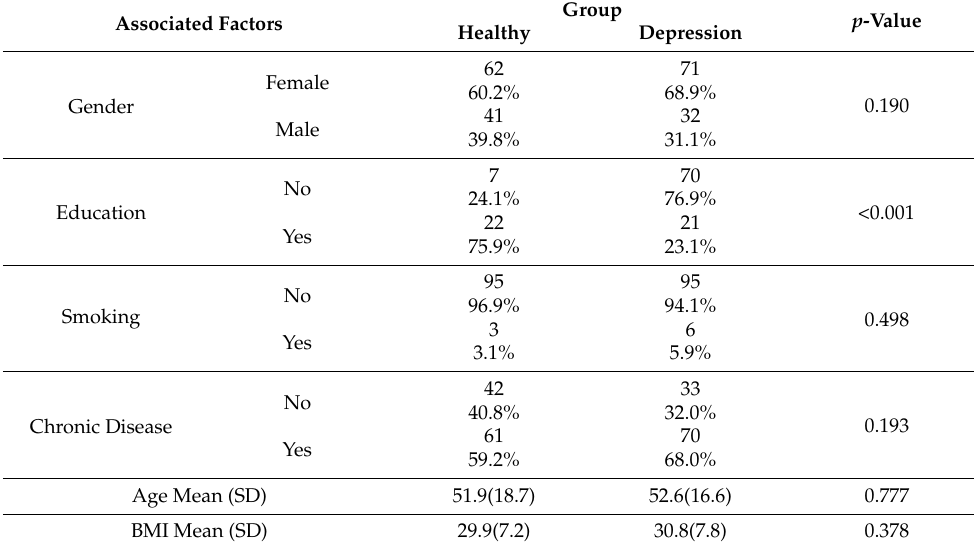
Table 1. Comparison of the Depressed Group vs. Healthy Group in the Demographic and Clinical Data.